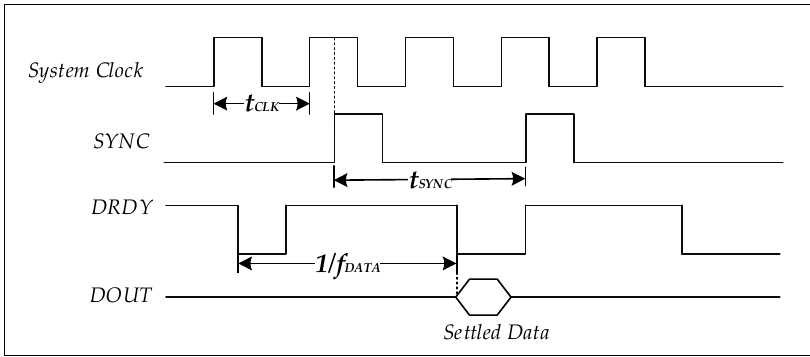
Figure 6. The timing for continuous-sync and data output mode.